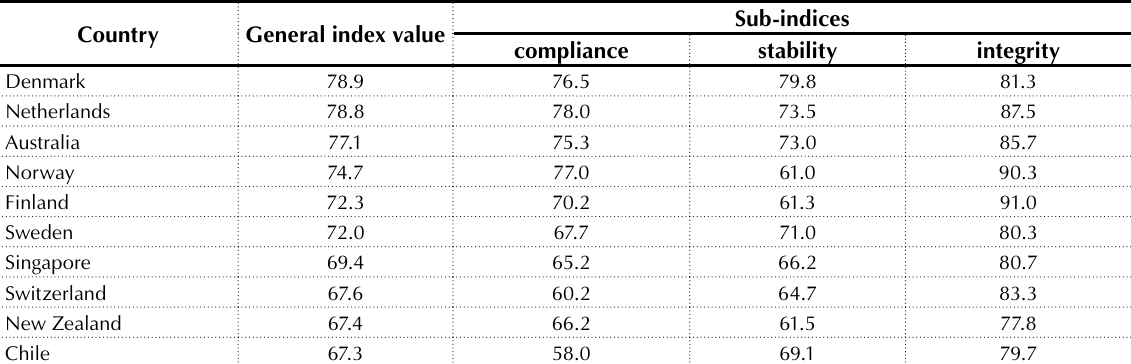
Source: Compiled based on Melbourne Mercer Global Index